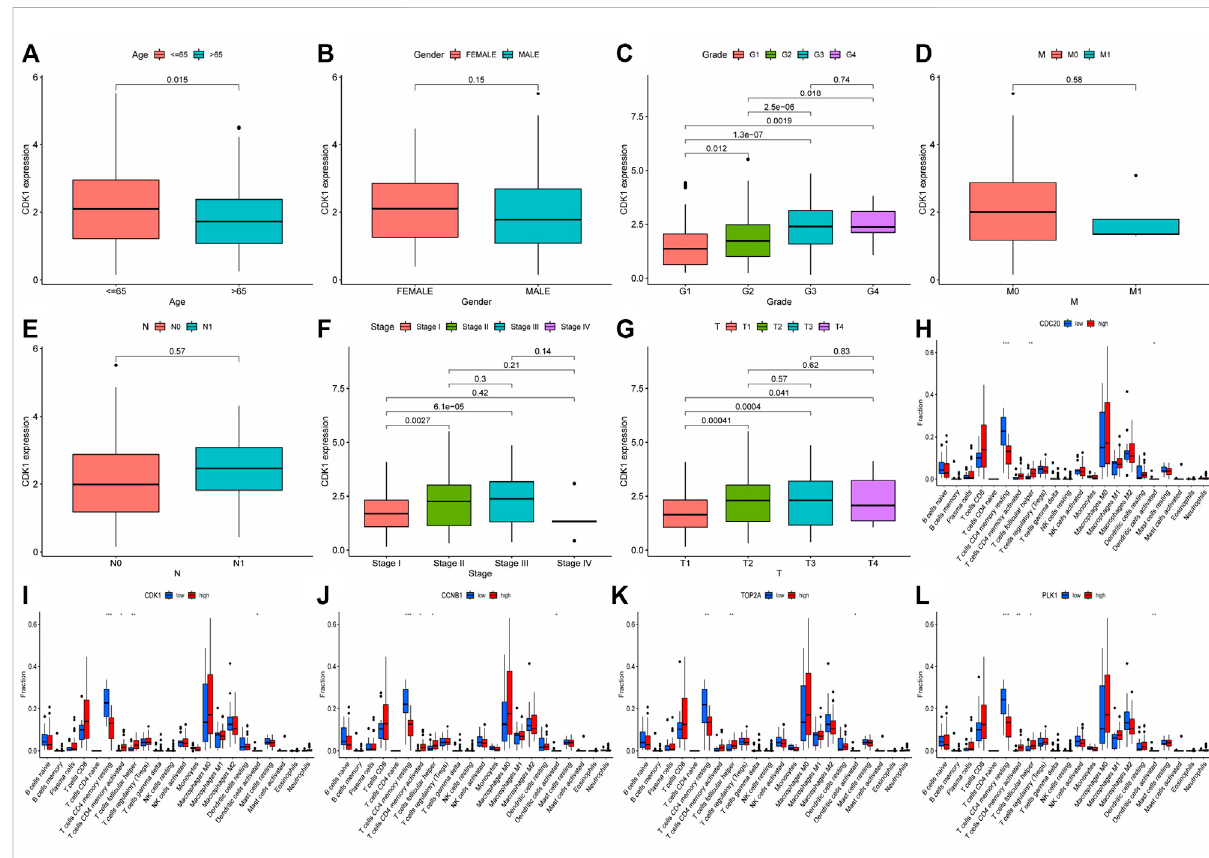
FIGURE 13 Analysisofclinicalandimmunecorrelationofcorenetworkgenes (A – G) Clinicalcorrelationanalysiswasperformedon10corenetworkgenes, including gender, age, TNM stage, Stage and Grade (CDK1 analysis was shown only, other result could be seen in supplementary documents (Data Sheet1); ( H – L) Immunocytein fi ltration of10coregenesinthenetwork wasanalyzed(only theresults ofthe fi rst fi vegeneswereshown, otherresult could be seen in supplementary documents (Data Sheet 2). * represented p < 0.05, ** represented p < 0.01, *** represented p <